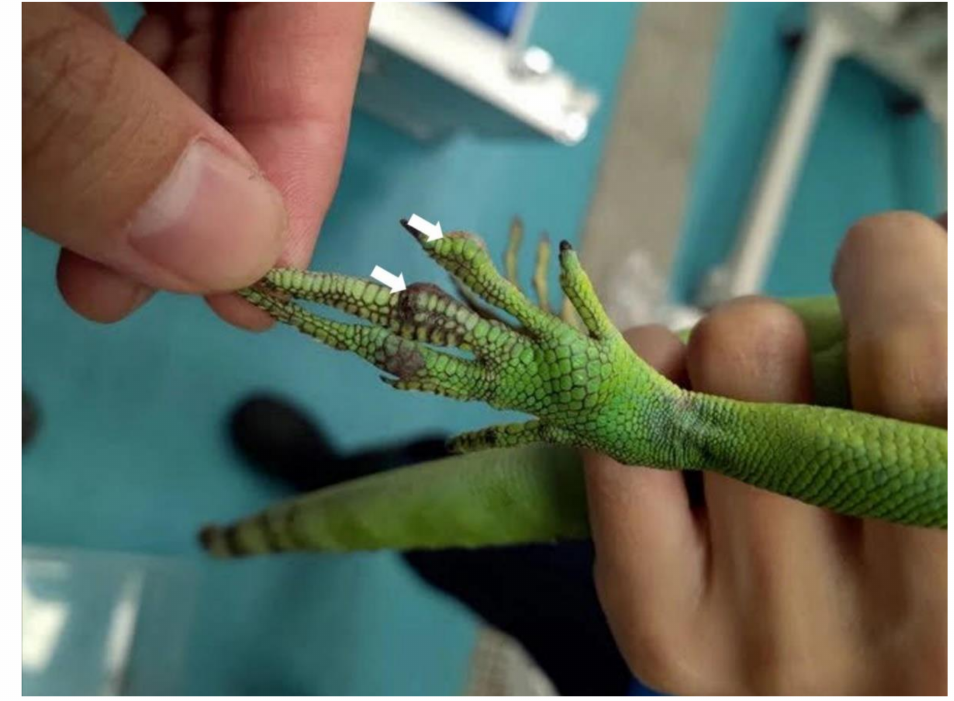
Figure 1. Two 0.2–0.5 cm ulcerative skin nodules on the left hind foot